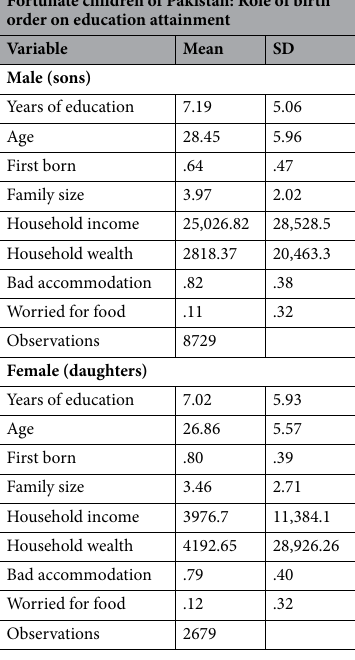
Table 1. Descriptive statistics sons and daughters. This table reports descriptive statistics (mean and s.d.) for sons (top panel) and daughters (bottom panel). Our main sample includes children aged above 22